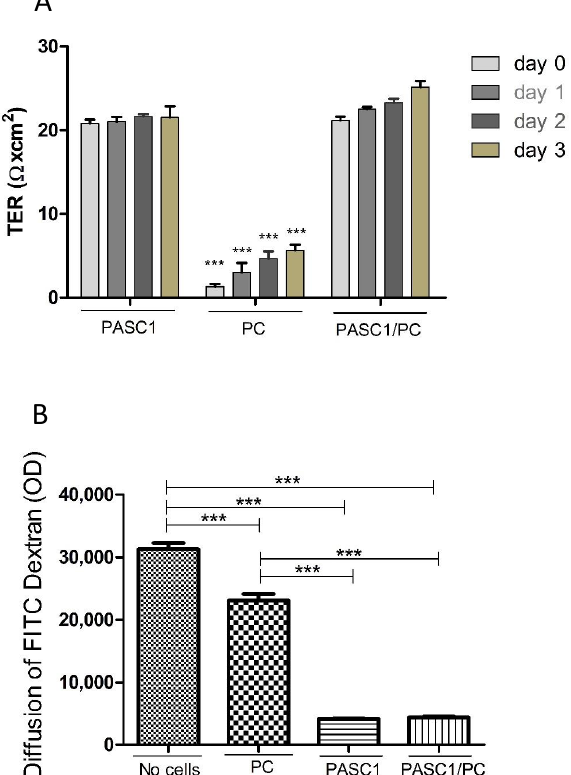
Figure 6. Time-dependent effects of different single cell types or co-cultures on barrier integrity. Monocultures of PASC1 showed a strong barrier, which was only slightly improved by co-cultures of PASC1/PCs, as shown by the TER values ( A ). Statistical tests were performed to evaluate differences between the distinct days and the distinct mono- and co-cultures; for example, day 0 showed a significant reduction only for PC compared to PASC1, and for the PASC1/PC co-culture, but the difference between PASC1 and PASC1/PC was not significant. Monocultures of PASC1 showed the strongest reduction of the diffused FITC-dextran after 48 h compared to PCs only ( B ). Co-cultures of PASC1/PCs only showed slightly higher reductions compared to mono-cultures of PASC1. Data points represent the mean values ± SEMs obtained from three independent repetitions performed in duplicates (n = 6); *** p <